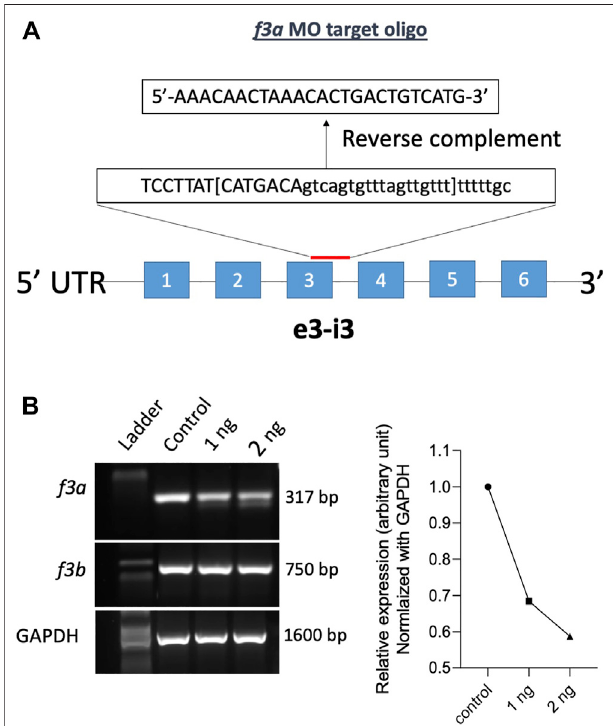
FIGURE 2 | f3a knockdown by Morpholino approach: (A) schematic diagram of f3a antisense morpholino oligonucleotide (MO) targeting the exon- intron junction (exon 3); design and synthesis by GeneTools (Oregon, United States). (B) The molecular targeting and ef fi ciency of f3a MO- injected with 1 and 2 ng of f3a was assessed by PCR and quanti fi ed using ImageJ.